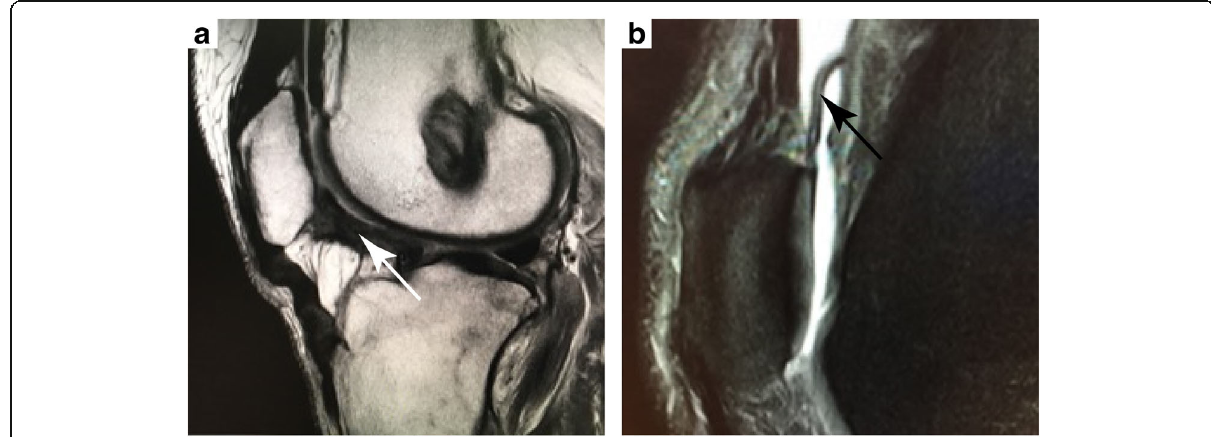
Fig. 1 MRI images showing arthrofibrotic adhesions (arrows) of the a anterior interval and b suprapatellar